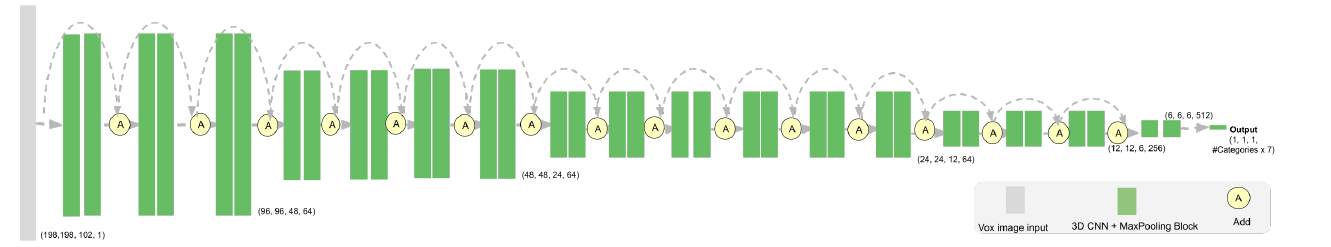
Figure 7. ResNetFCN35 network